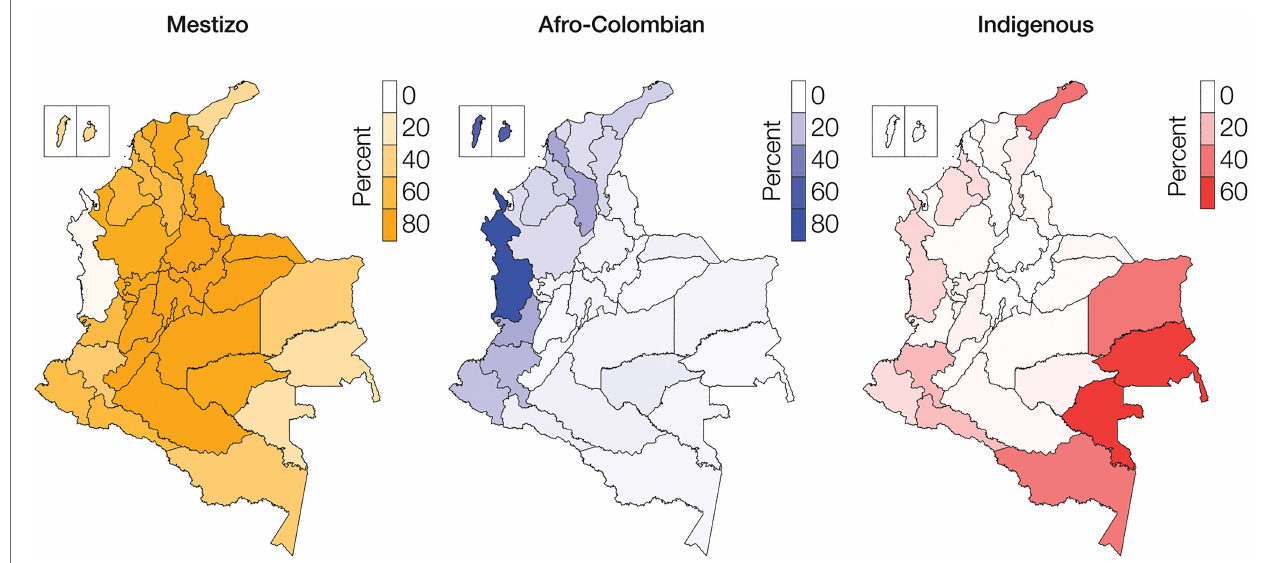
FIGURE 1 | Ethnic groups geographic distributions. Percentages of Mestizo (orange), Afro-Colombian (blue), and Indigenous (red) populations among Colombia’s administrative